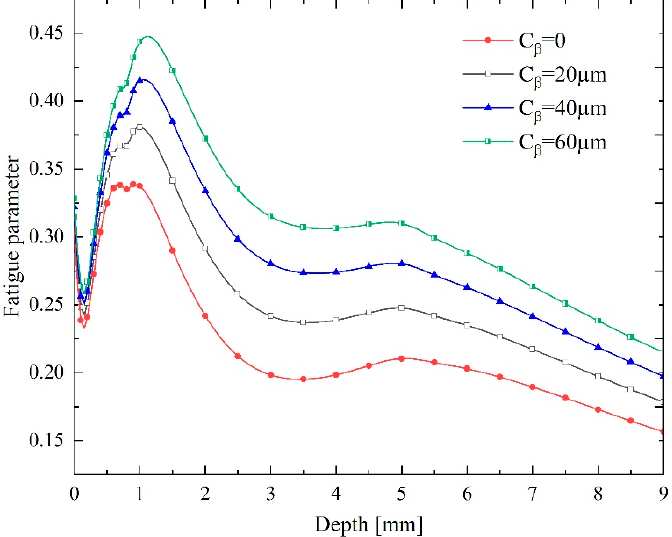
Figure 18. The e ff ect of crowning on the unit length load, ( a ) C β = 0, ( b ) C β = 20 µ m, ( c ) C β = 40 µ m, Figure 18. The effect of crowning on the unit length load, ( a ) C (cid:2962) = 0 , ( b ) C (cid:2962) = 20 μm , ( c ) C (cid:2962) = 40 μm , ( d ) C β = 60 µ m. Metals 2020 , 10 , x FOR PEER REVIEW ( d ) C (cid:2962) = 60 μm .